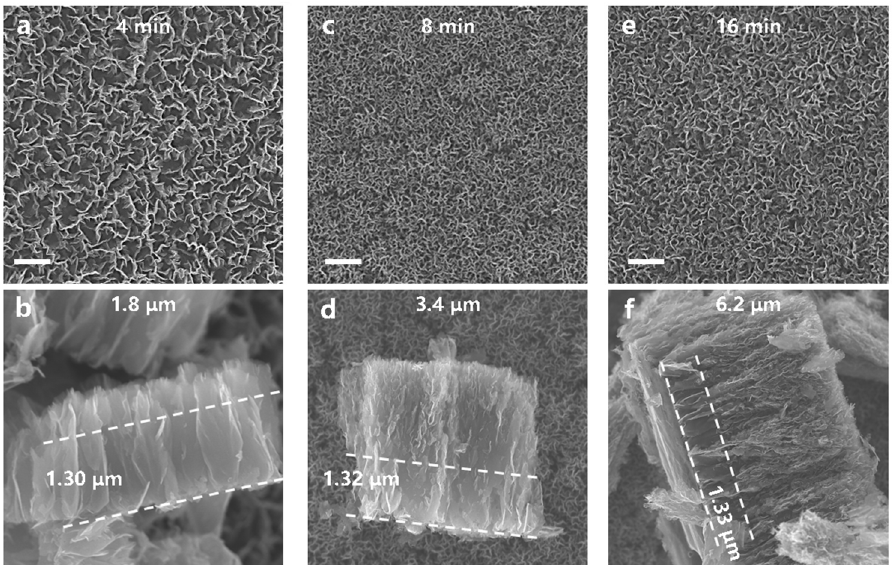
Figure 2. SEM images of morphologies of VG deposited on mica with different growth times. Top-view ( a ) and cross-sectional ( b ) images of VG with 4 min growth time; the total height is 1.8 µ m and the height of the smooth section is 1.3 µ m. Top-view ( c ) and cross-sectional ( d ) images of VG with 8 min growth time; the total height is 3.4 µ m and the height of the smooth section is 1.32 µ m. Top-view ( e ) and cross-sectional ( f ) images of VG with 16 min growth time; the total height is 6.2 µ m and the height of the smooth section is 1.33 μ m. The scale bars are 1 μ m.